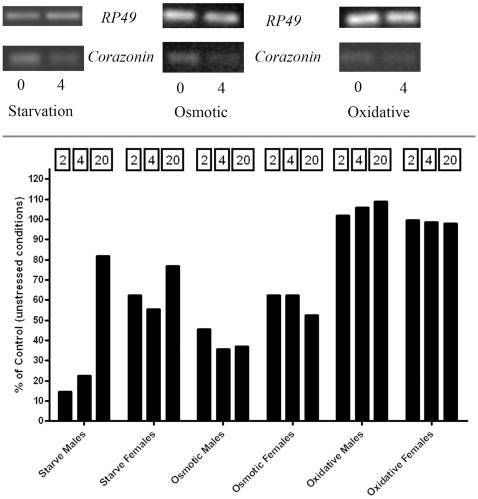
Corazonin transcript levels decrease during stress.
Top: Representative gels from experiments of corazonin and RP49 expression in the w1118 genotype under starvation, osmotic, and oxidative stress. Bottom: Changes in corazonin expression under different stresses for noted times. Data are represented as a % of basal (unstressed) and are normalized to RP49. Starvation and osmotic stress cause a decline in corazonin expression and rises as a function of stress duration. Oxidative stress produces no change in corazonin expression.